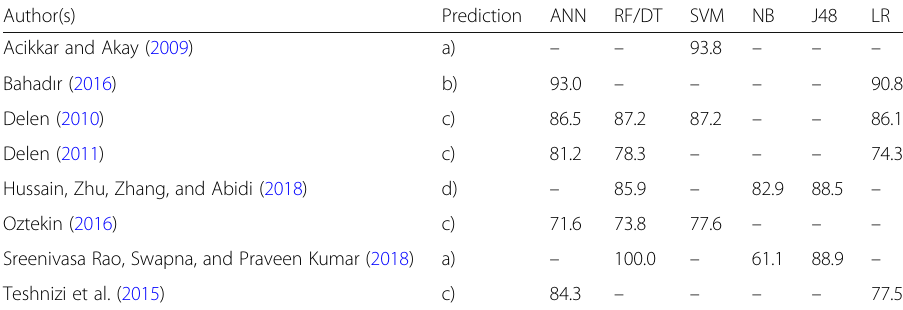
Table 7 Average performance of machine learning algorithms and logistic regression (%) Author(s) Prediction ANN